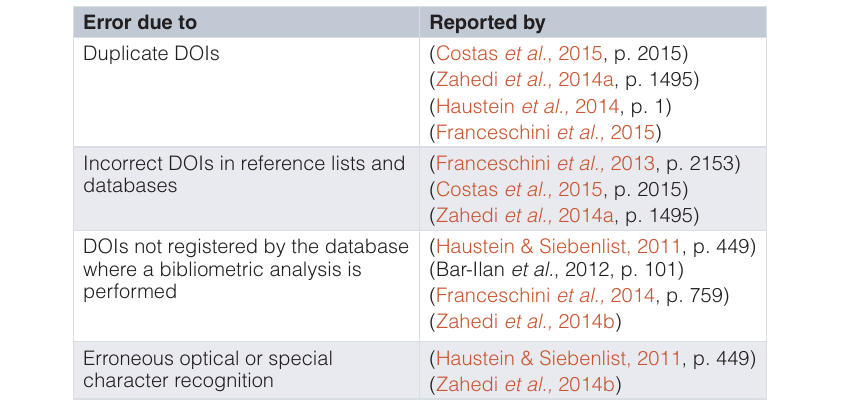
Table 1. Precision - types of